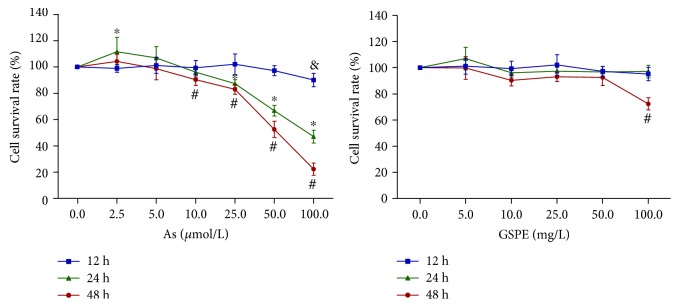
Viability changes of L-02 cells after arsenic or grape seed procyanidin extract treatment (mean and 95% CI). Cell viability was detected by MTT assay. &12 h versus the control group, P < 0.05; ∗24 h versus the control group, P < 0.05; #48 h versus the control group, P < 0.05. CI: confidence interval. Cell viability decreased significantly with increase in concentration and intervention time of arsenic. GSPE had no significant effect on cell viability.